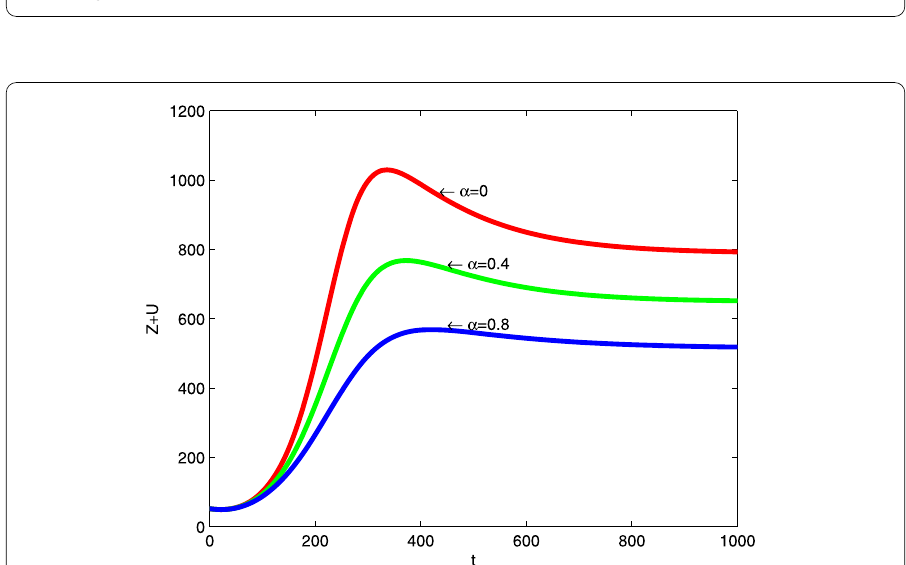
Figure 5 Time series plot of the total infectious tree population with different vaccination